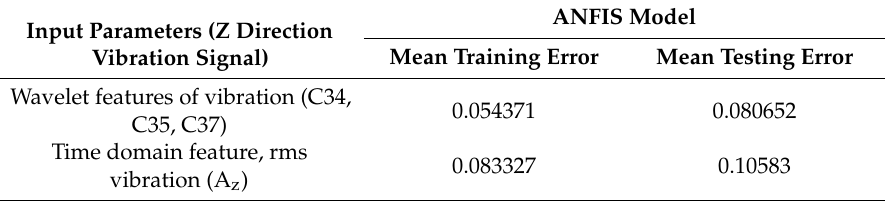
Table 3. Performance comparison of wavelet features and time feature by ANFIS